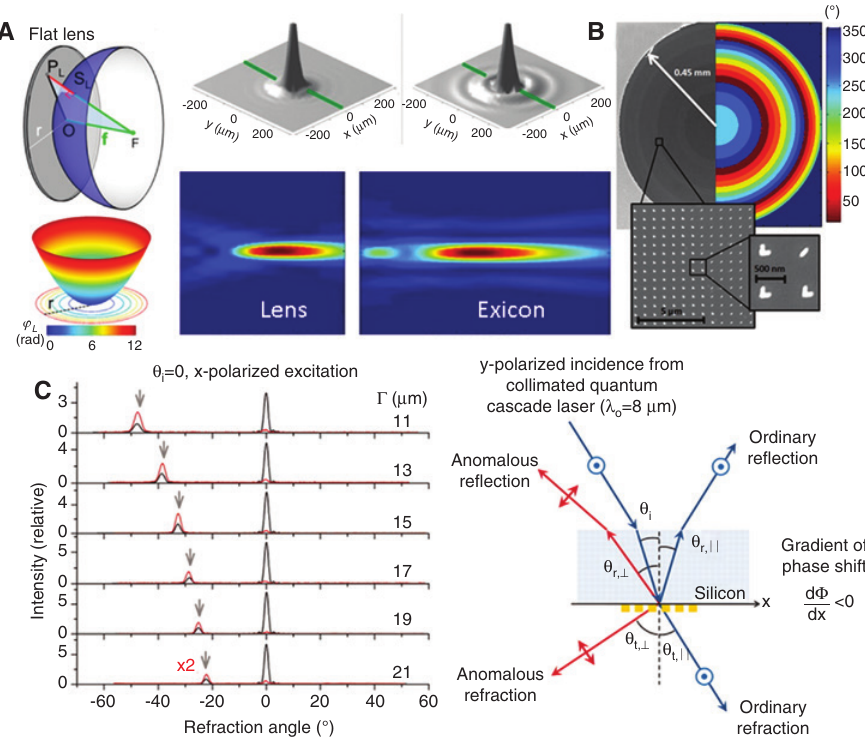
Figure 4: Plasmonic transmit arrays applications. (A); (B) Plasmonic metalenses. Adapted with permission from Ref. [41]. Copyright 2012 American Chemical Society; (C) plasmonic deflector/prism. From Ref. [5]. Reprinted with permission from